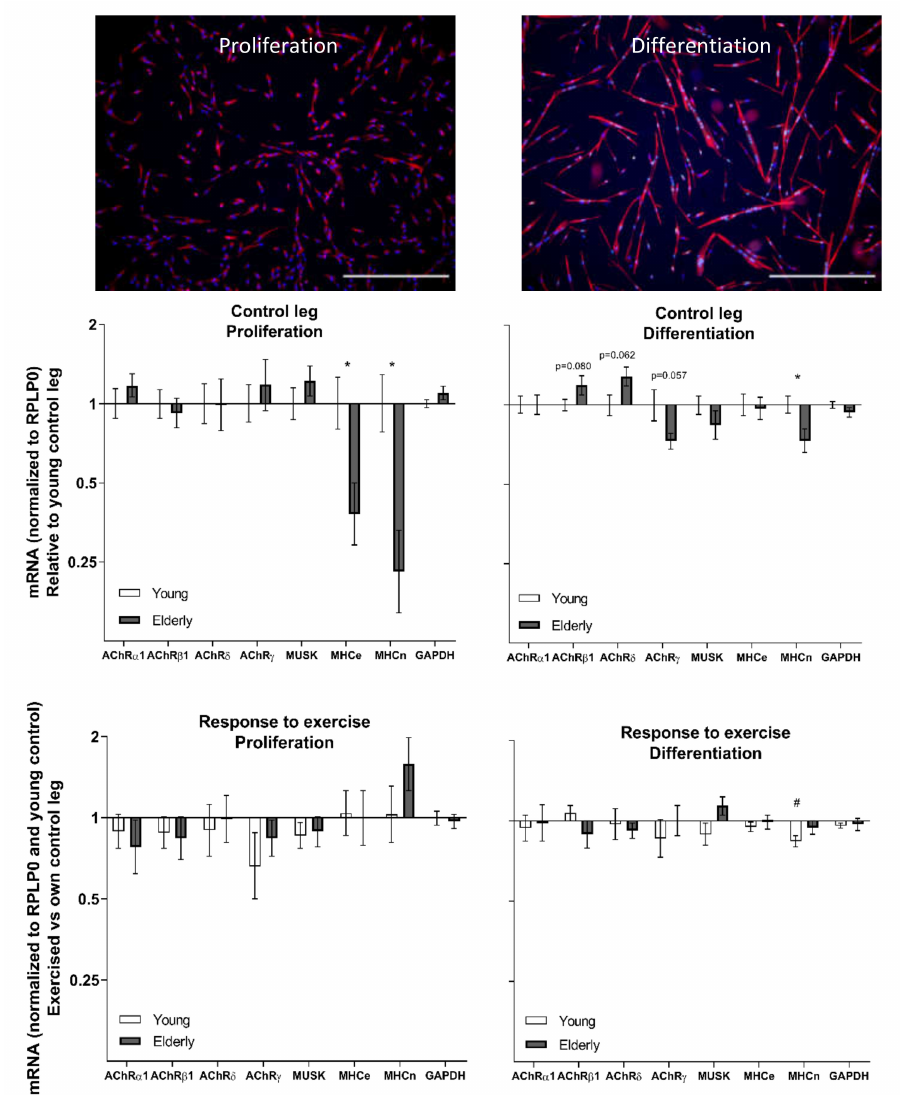
Figure 4. Images display cells in the proliferation condition (Desmin, red, and DAPI, blue) and in the di ff erentiation condition (Desmin, red, Myogenin, green, and DAPI, blue), scale bars = 500 µ m. Gene expression in cell cultures from the control and exercised legs of healthy young ( n = 12) and elderly ( n = 11) women. mRNA data were normalized to RPLP0 and are shown as geometric means ± back-transformed SEM, relative to young control leg (control leg) and own control leg (response to exercise). * p < 0.05 elderly vs. young. # p < 0.05 vs. control leg. Tendencies are written. AChR: acetylcholine receptor; MuSK: muscle-specific-kinase; MHCe: embryonic myosin heavy chain; MHCn, neonatal myosin heavy chain; NCAM, neural cell adhesion molecule; GAPDH: Glyceraldehyde-3-Phosphate Dehydrogenase; RPLP0: Ribosomal Protein Lateral Stalk Subunit